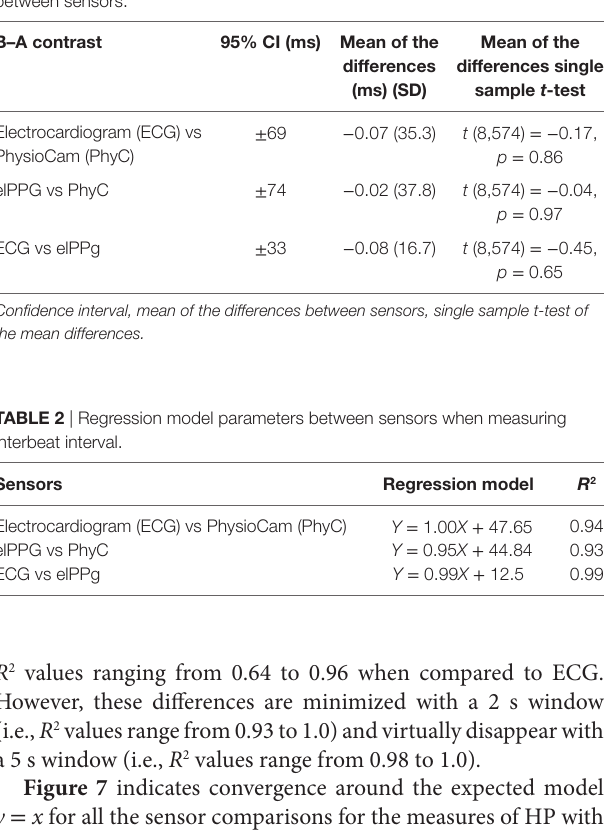
TaBle 1 | Bland–Altman (B–A) contrast parameters for interbeat interval between